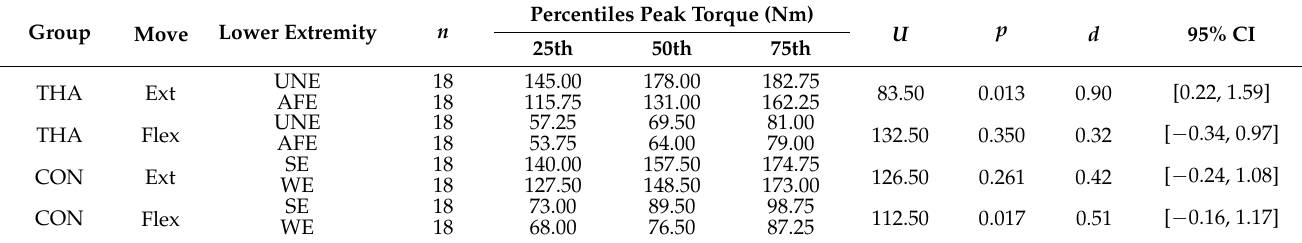
Table 2. Evaluation of the bilateral strength imbalances in the THA and CON groups.